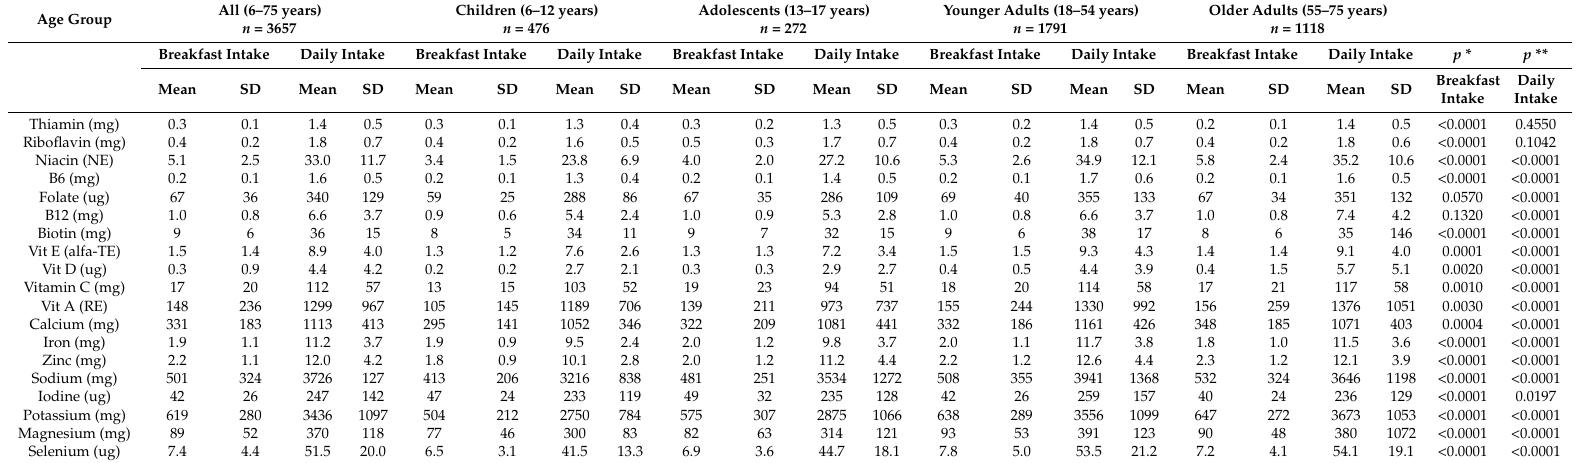
Table 3. The intake of micronutrients at breakfast and for the total day according to age in